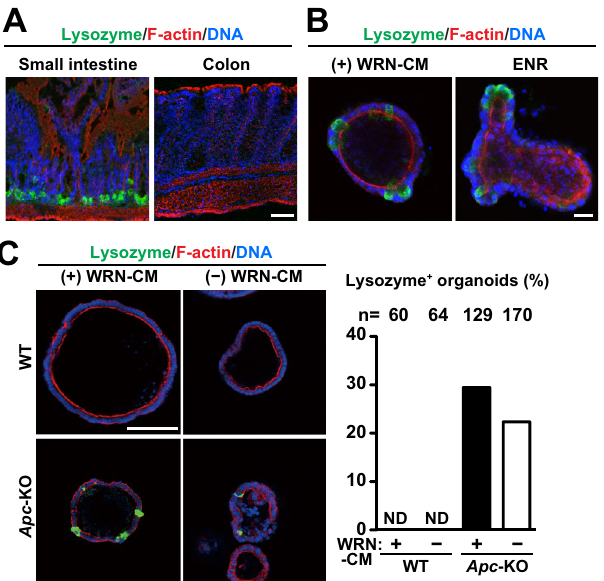
Figure 6. Ectopic emergence of lysozyme-positive cells in Apc -KO organoids. ( A ) Sections of the small intestine and colon dissected from WT mice were subjected to immunofluorescence staining for lysozyme (green). Counter stain, phalloidin for F-actin (red) and DAPI for DNA (blue). Scale bar, 50 μm. ( B ) Organoids derived from the small intestine were cultured in the presence of WRN-CM (left) or in ENR medium (right). ENR medium contains EGF, noggin and R-spondin1-CM but not Wnt (see Methods). The organoids were stained with anti-lysozyme antibody (green). Scale bar, 20 μm. ( C ) Colon organoids formed in the presence of WRN-CM were cultured in the presence or absence of WRN-CM for 3 more days. They were stained with anti-lysozyme antibody (green). The ratio of organoids containing at least one lysozyme-positive cell to total organoids was quantified for each group. The total number of organoids analyzed is shown above each bar. ND not detected. Scale bar, 100